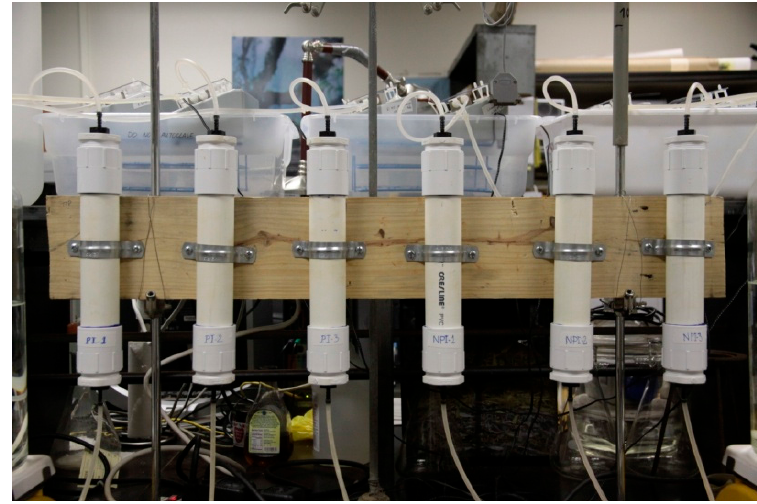
Figure 1. The microcosm MSL systems.